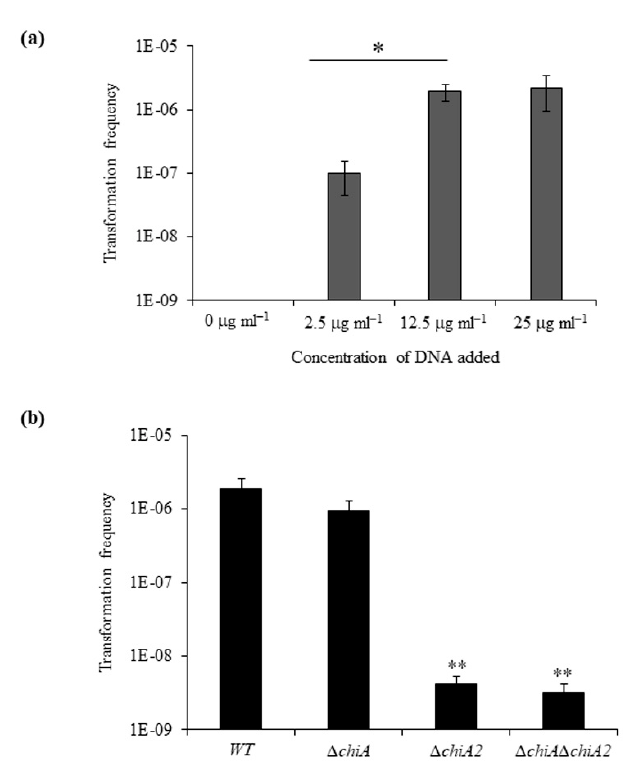
Figure 2. ChiA2 is essential for chitin-induced natural transformation ( a ) WT strain incubated with increasing concentration of extracellular DNA for natural transformation. ( b ) WT and isogenic mutant strains ∆ chiA , ∆ chiA2 and ∆ chiA ∆ chiA2 were naturally transformed on shrimp chitin flakes with 12.5 µ g / mL extracellular DNA. Average of at least three independent experiments were represented. * Statistically significant di ff erence between lowest and other concentrations of donor gDNA ( p < 0.05); ** Statistically significant di ff erence between the transformation frequency of WT and mutant strains ( p < 0.05).